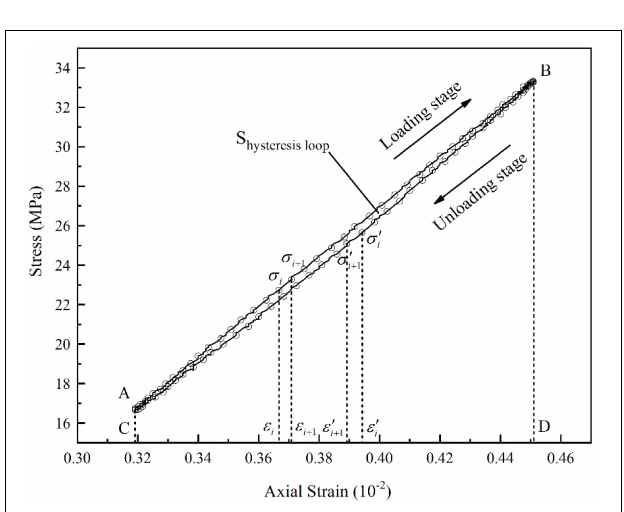
FIGURE 6 | Comparison of fracture morphologies.